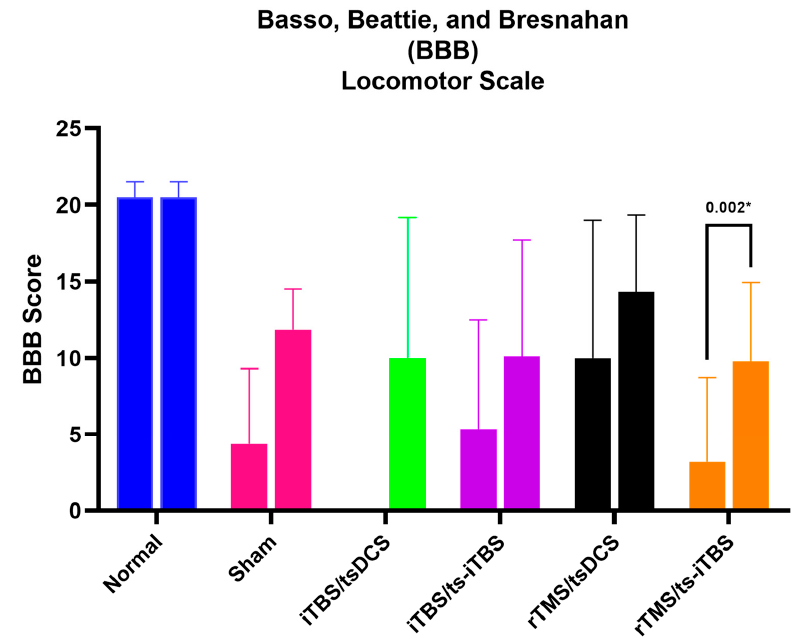
Figure 9. Basso, Beattie, and Bresnahan (BBB) scores for all six groups post ‐ week 1 vs. post ‐ week 4 interventions. d; effect size for sham ( − 1.22), iTBS/tsDCS ( − 1.09), iTBS/ts ‐ iTBS ( − 1.07), rTMS/tsDCS ( − 1.07), and rTMS/ts ‐ iTBS ( − 3.23). The level of signi fi cance was set to p < 0.050 *. Table 5. BBB score comparison using one ‐ way ANOVA with group factor ( n = 24). Sum of